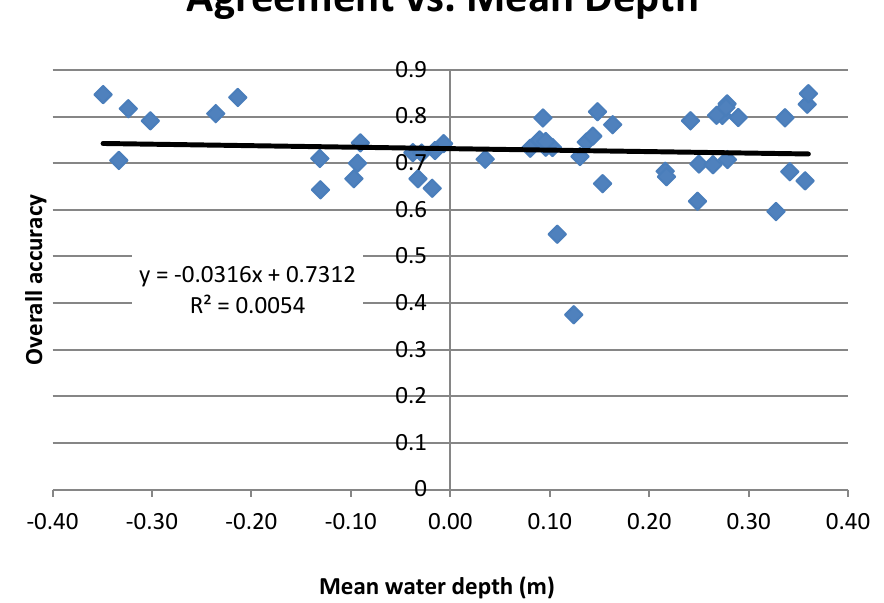
Figure 19. Regression of agreement against mean depth for all 50 image study dates.